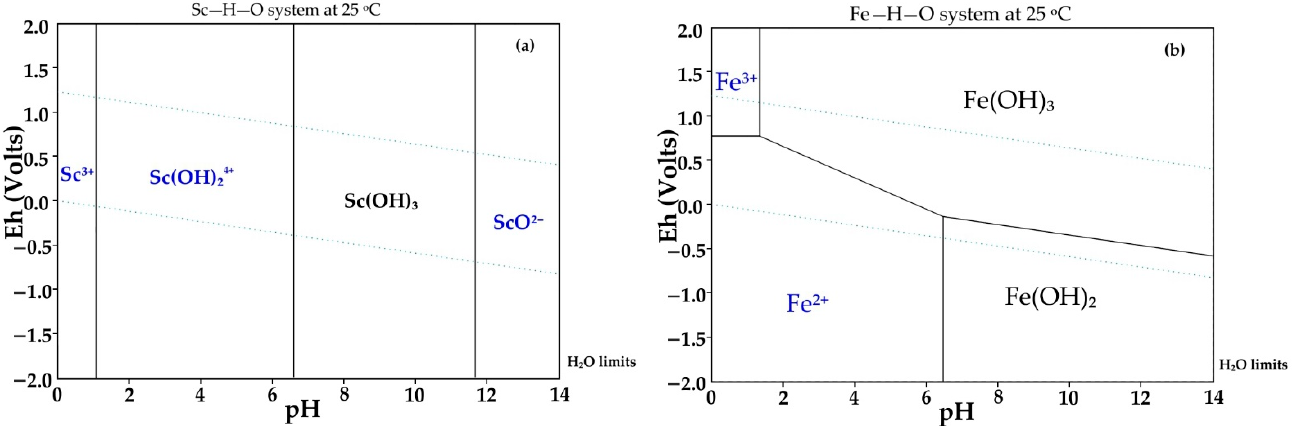
Figure 4. Thermodynamic modeling of: ( a ) the system Sc–H–O at 25 °C; and ( b ) the system Fe–H–O. The optimal pH range was defined as 2–3.5 for a higher Sc extraction selectivity and leaching rate. The effect of temperature (T, °C), leaching time ( τ , min), pH, and liquid to solid ratio (L:S) on the Sc extraction with HNO 3 from RMF is shown in Figure 5. A Pareto chart was constructed to estimate the standardized effect of each parameter on Sc extraction (Figure 5d).